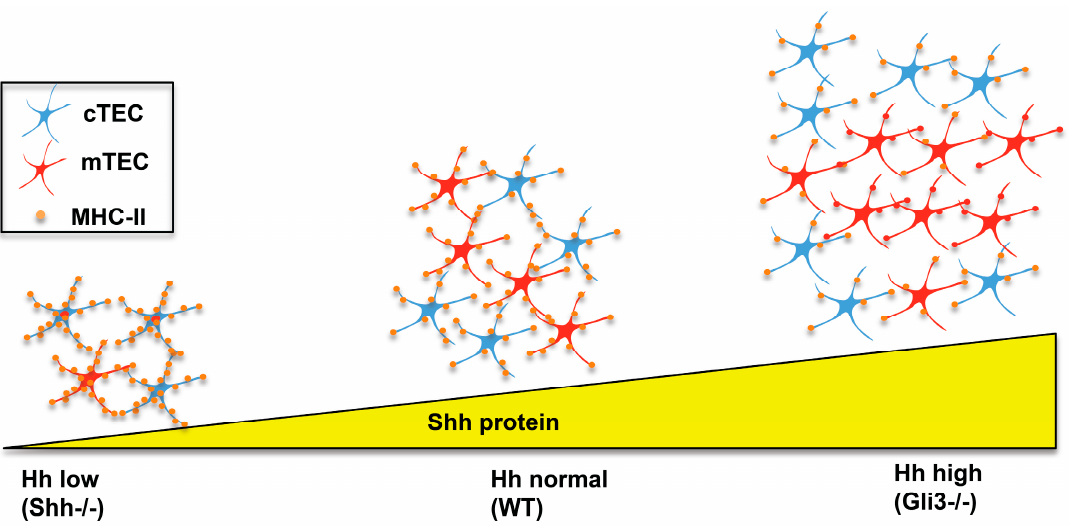
Figure 5. Impact of Shh-deficiency and Gli3-deficiency on TEC differentiation and function. In the Shh − / − embryonic thymus, Hh protein levels are low, there are fewer TEC, and the ratio of mTEC (shown in red) to cTEC (shown in blue) is decreased, but expression of MHCII is increased on individual TEC, compared to WT. In the Gli3 − / − embryonic thymus—which has increased levels of Hh pathway activation—the opposite phenotype is seen. TEC numbers are increased, but MHCII expression on individual TEC is reduced compared to WT.